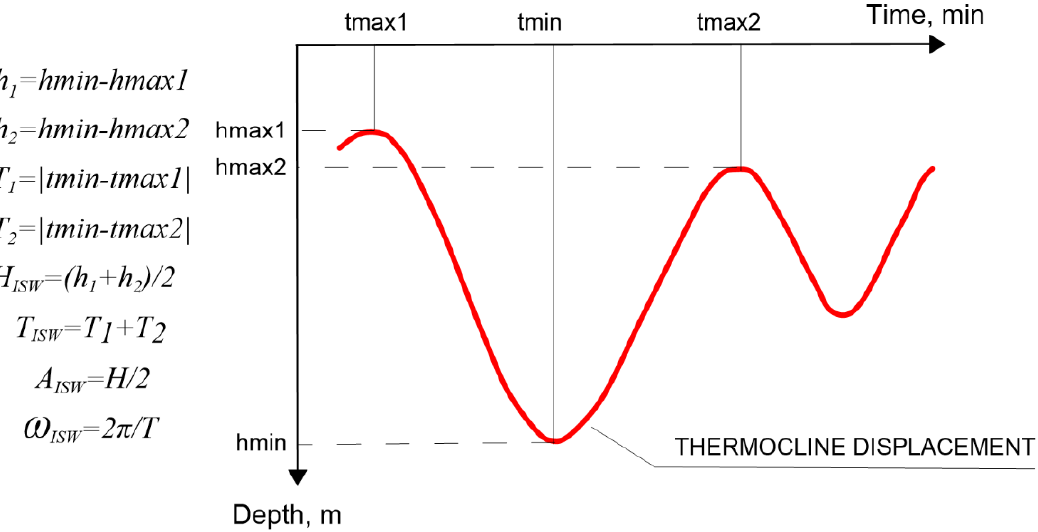
Figure 3. Schematic of the ISW height and period retrieval from vertical CTD casts.